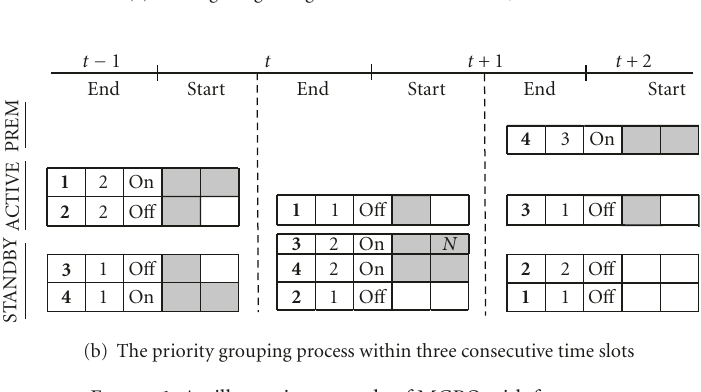
Figure 1: An illustrative example of MGPQ with four